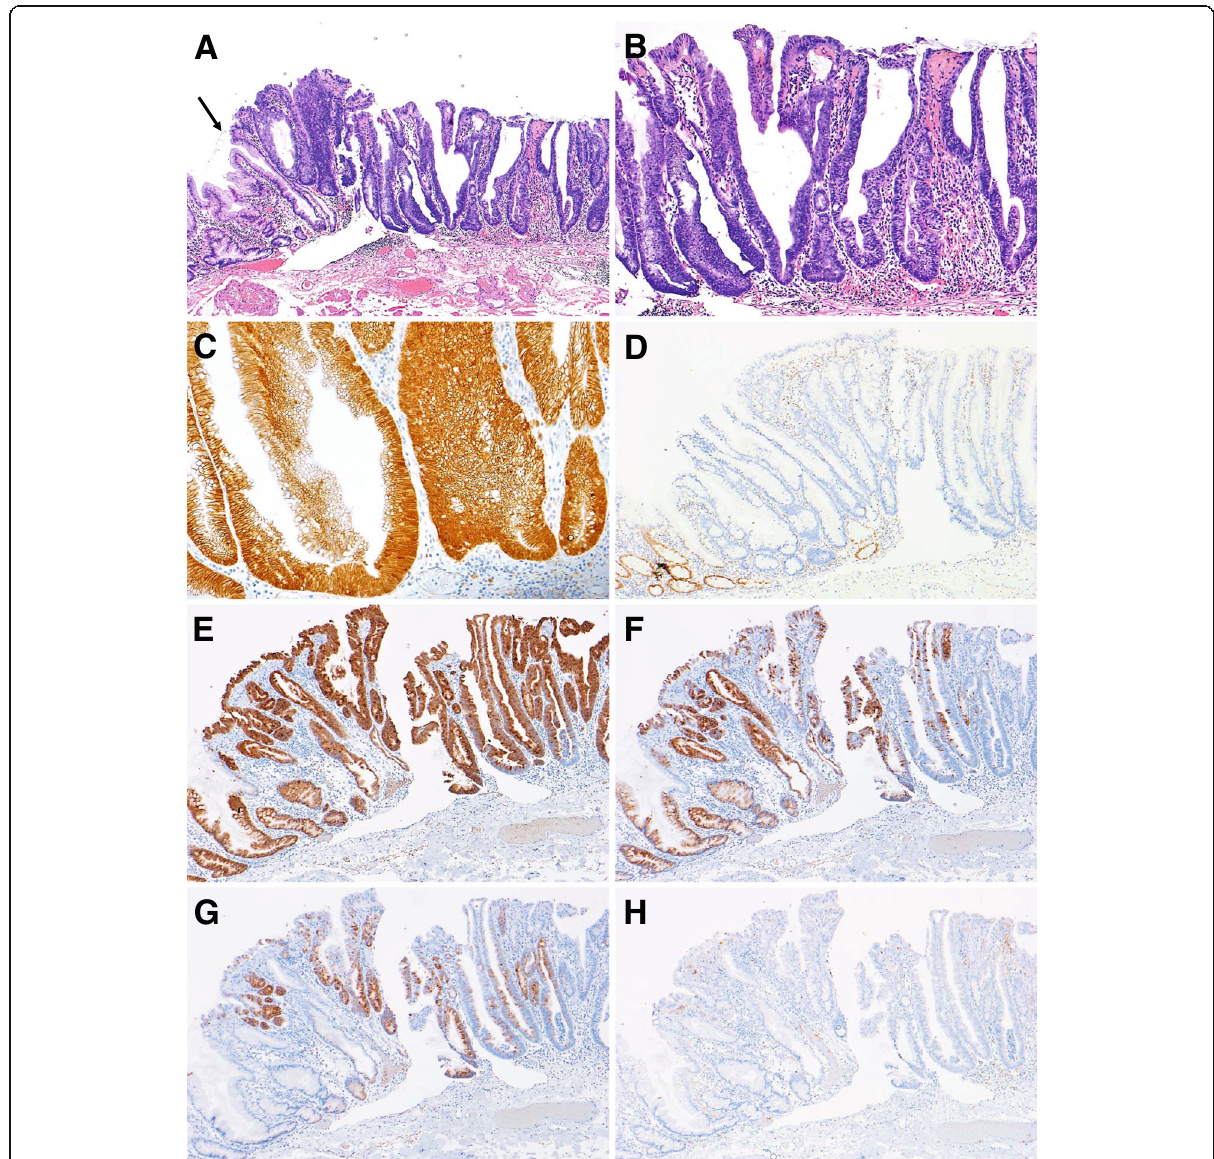
Fig. 2 Immunohistochemical staining in a representative case of sessile serrated adenoma/polyp (SSA/P) with dysplasia (Case #2). a Dilated crypts and deep serration, corresponding to SSA/P, were seen on the left side, and high-grade dysplasia without submucosal invasion was seen on the right side. An abrupt transition was seen between the 2 adjacent regions (arrow). b High-power field of ( a ) (the right side). A view shows high- grade dysplasia without submucosal invasion, which was pathologically consistent with SSA/P with cytologic dysplasia. The lesion showed nuclear β - catenin expression ( c ) and a loss of MLH1 expression ( d ). Regarding phenotypic mucin expression, the lesion was positive for MUC2 ( e ), MUC5AC ( f ), and MUC6 ( g ) expression, and negative for CD10 (H)